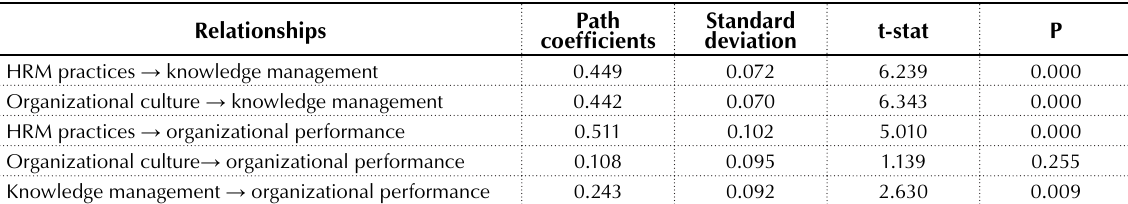
Table 3. The analytical results of direct